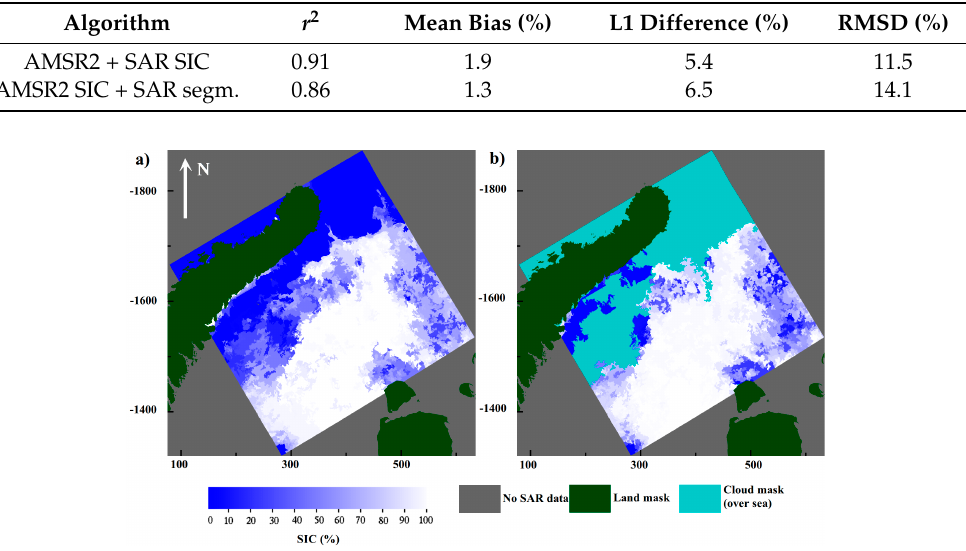
Figure 19. ( a ) SENTINEL-1 SAR and AMSR2 radiometer based SIC chart [45], and ( b ) SIC chart from the MODIS OWSI chart on 9 June 2016. The charts cover an area in the Kara Sea between the Novaya Zemlya and the Yamal Peninsula. X - and y -axis show easting and northing in km. Table 4. Validation statistics for the sea ice concentration estimation using the SENTINEL-1 SAR and segm. Sea ice concentration validation data were retrieved from the MODIS OWSI charts for March to June 2016. Table 5. Validation statistics for the sea ice concentration estimation using the SENTINEL-1 SAR and AMSR2 radiometer data and two different algorithms: AMSR2 + SAR SIC and AMSR2 SIC + SAR segm. Sea ice concentration validation data retrieved from the MODIS SIT charts for November 2015 to April